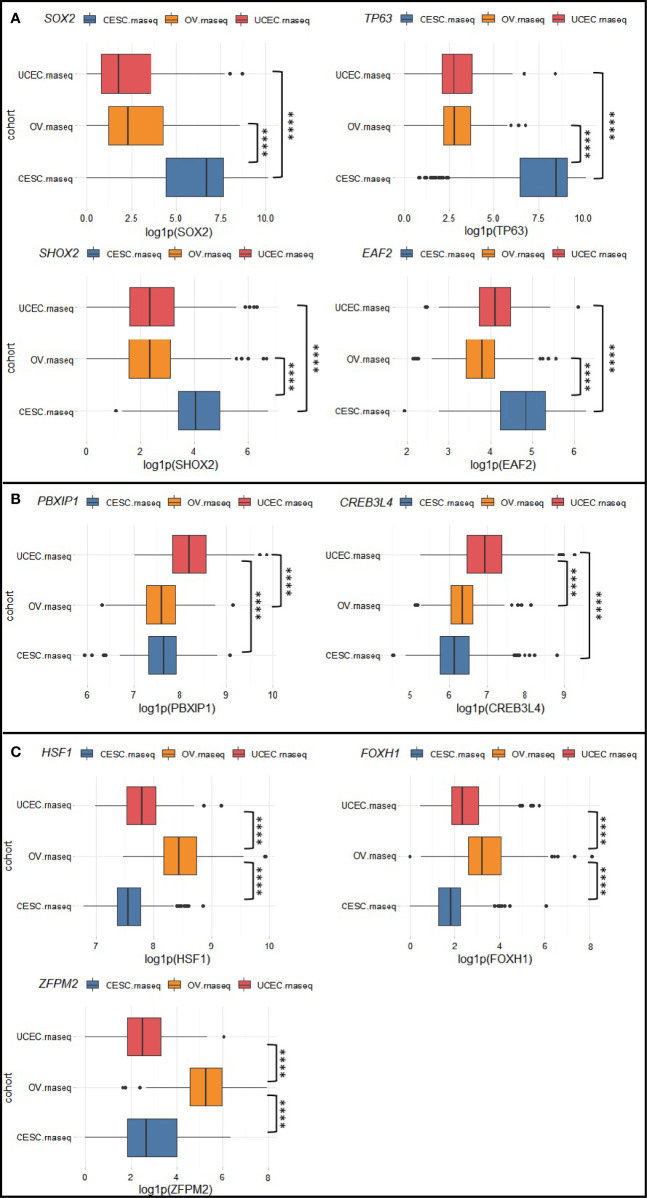
Exclusively altered transcription factors for (A) cervical cancer, (B) endometrial cancer, and (C) ovarian cancer. Box plots show the natural logarithm of (1 + expression value) of TCGA-CESC, TCGA-UCEC, and TCGA-OV drawn from RTCGA.rnaseq package. ****p < 0.0001.